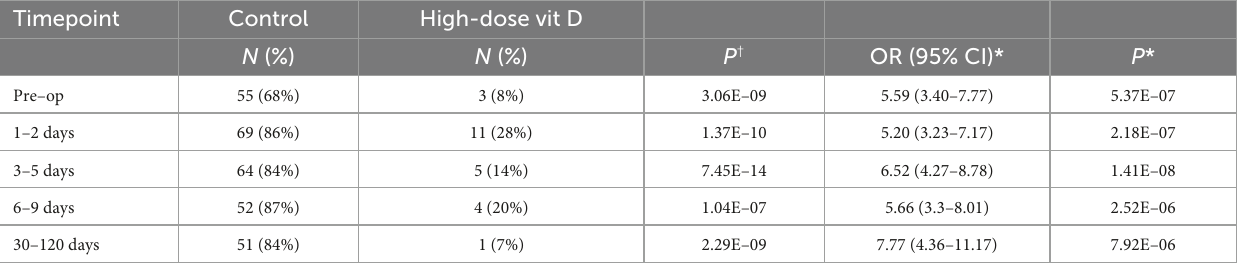
TABLE 2 25-hydroxyvitamin D (25OHD) insufficiency at each peri-operative timepoint in control and supplemented patients.